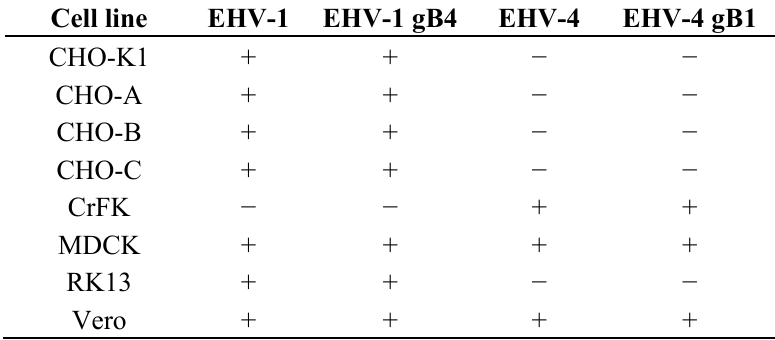
Table 2. The role of gB in EHV-1 cellular